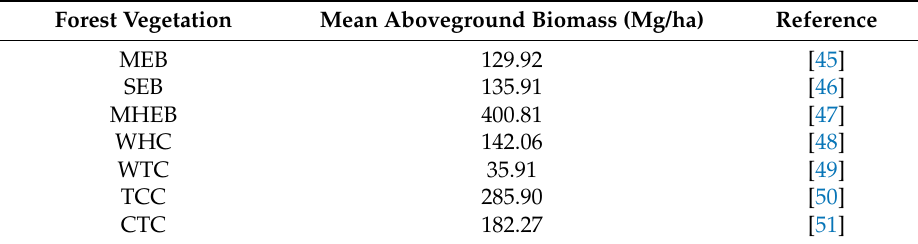
Table 3. The mean forest vegetation biomass of seven forest types in Yunnan Province. Forest